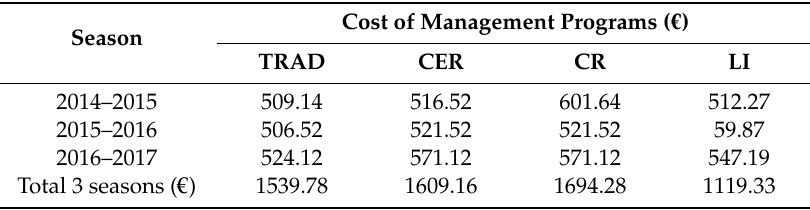
Table 4. Economic cost ( € ) of di ff erent agronomic tasks carried out in each management program during three seasons. See text for more details.